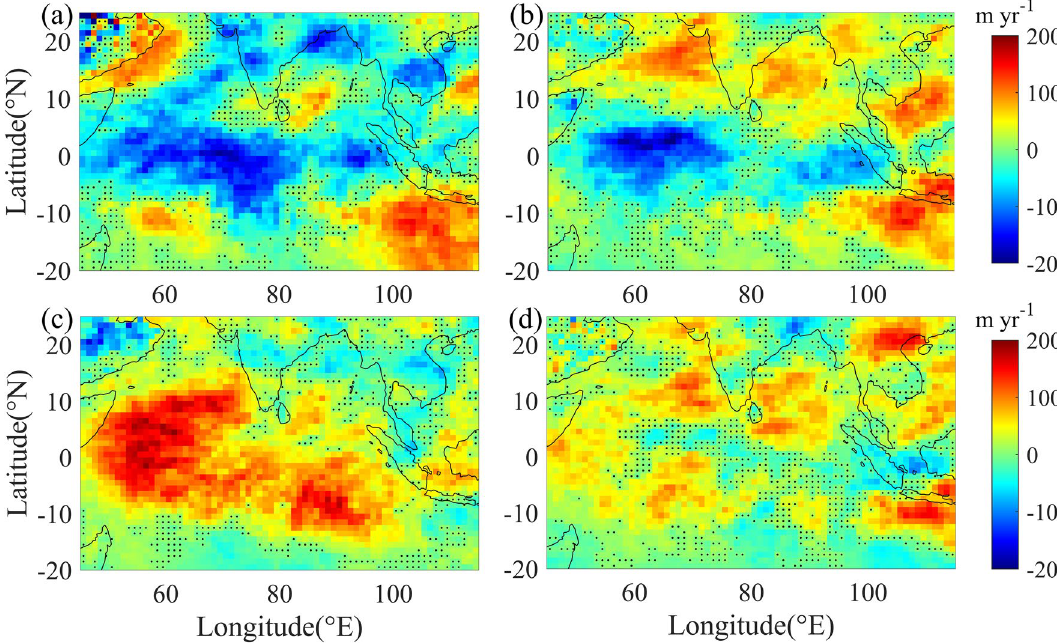
Figure 1. Spatial variations in trends of CTH in summer monsoon months: Spatial variations of trends in CTH from MODIS-Terra during 2000 to 2017, in the months of ( a ) June, ( b ) July, ( c ) August and ( d ) September. Positive values show the regions, where CTH is increasing and negative values indicate those, where CTH is decreasing. Linear trend of CTH in each pixel and its statistical significance are estimated using the trend analysis technique detailed in the method section. All the pixels, except those with black dots, show the regions where estimated trends are statistically significant at 95% confidence level. The map is generated using MATLAB 2020a, www. mathw orks.